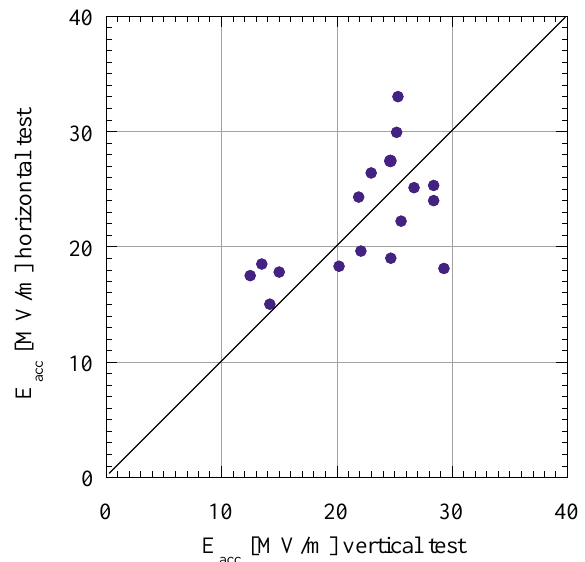
FIG. 22. Comparison of vertical and horizontal test results. The average accelerating field achieved in the vertical test with cw excitation is 22.3 MV (cid:1) m, in the horizontal test with pulsed excitation 22.5 MV (cid:1) m. Most of these cavities are from the second production.